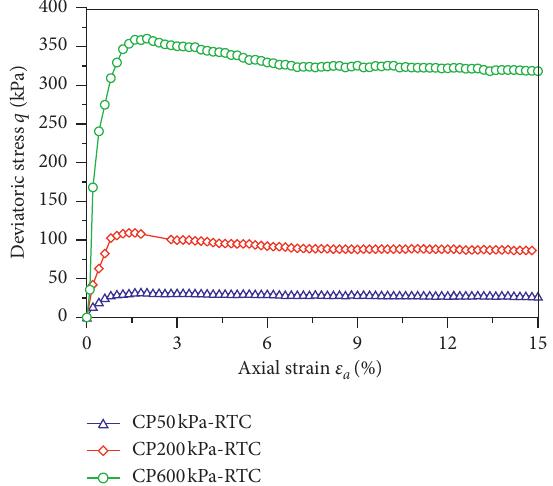
Figure 5: Undrained stress-strain relation of Jingyang loess under the RTC stress